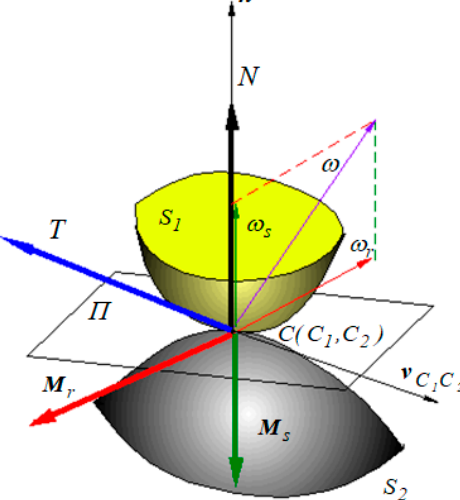
Figure 3. The friction torsor at a point of contact.